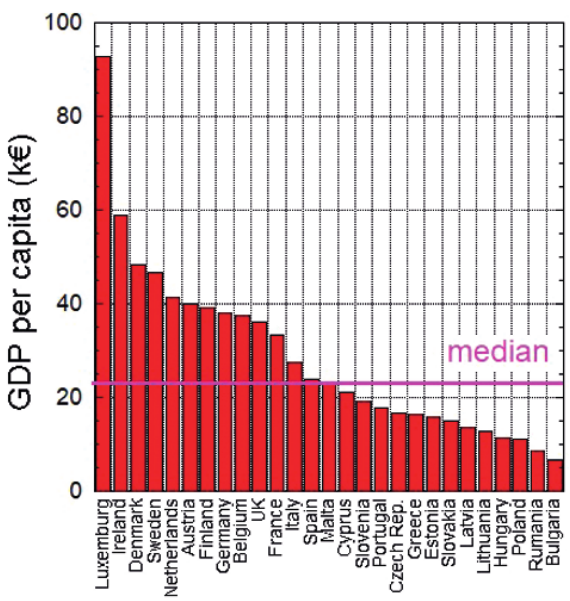
Fig. 5. – Distribution of the GDP per person in Europe.